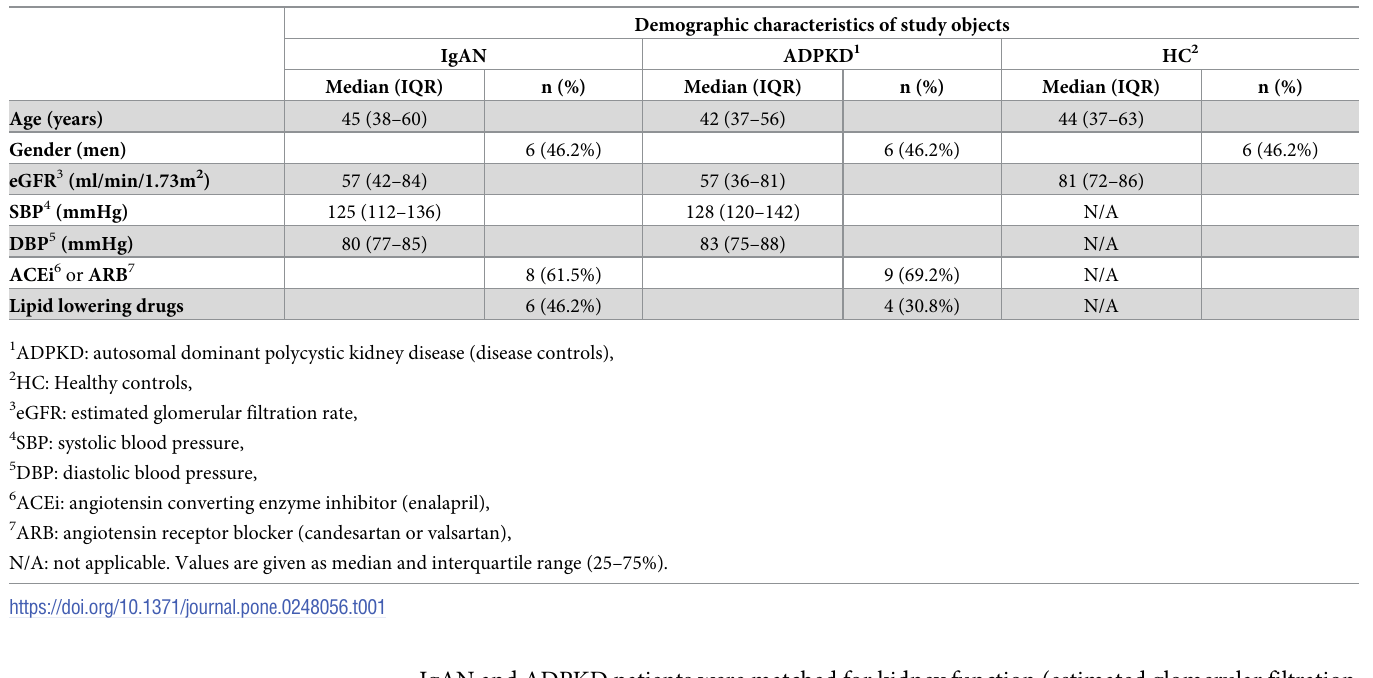
Table 1. Baseline characteristics of study